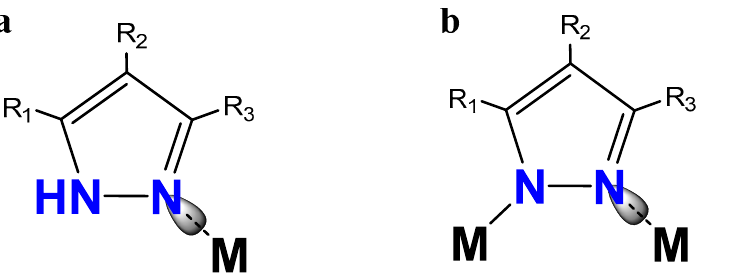
Scheme 1. Chemical structures of non-deprotonated pyrazole coordinated to metal via a lone pair of N atom ( a ) and py- razolate anion in the bridging mode ( b